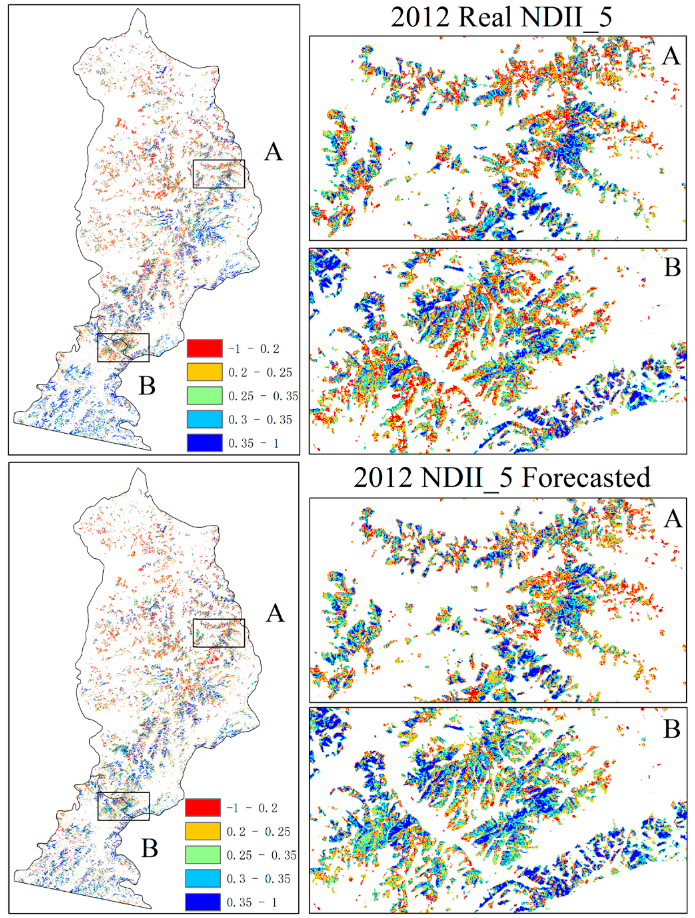
Figure 12. The comparison of the predicted NDII5 and the real NDII5 maps of the study area in the year 2012. Places A and B are the two same regions zoomed in.